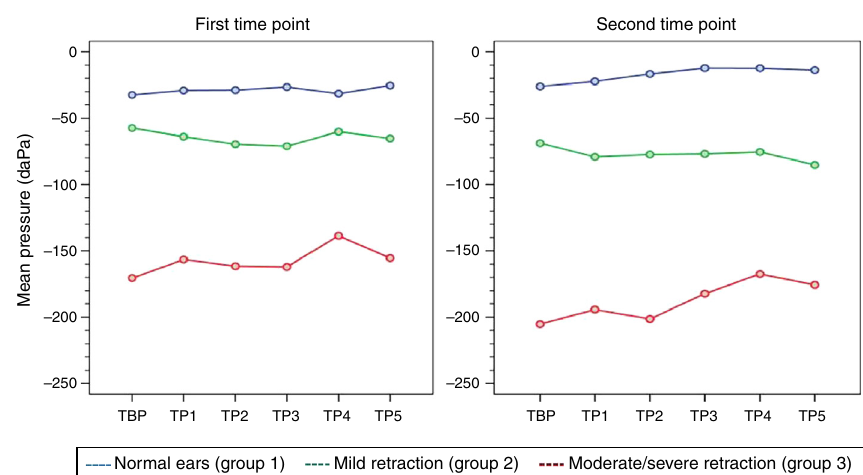
Normal ears (group 1) Mild retraction (group 2) Moderate/severe retraction (group 3) Variability of mean middle ear pressure measurements during the Toynbee maneuver at the first and second time points of assessment.